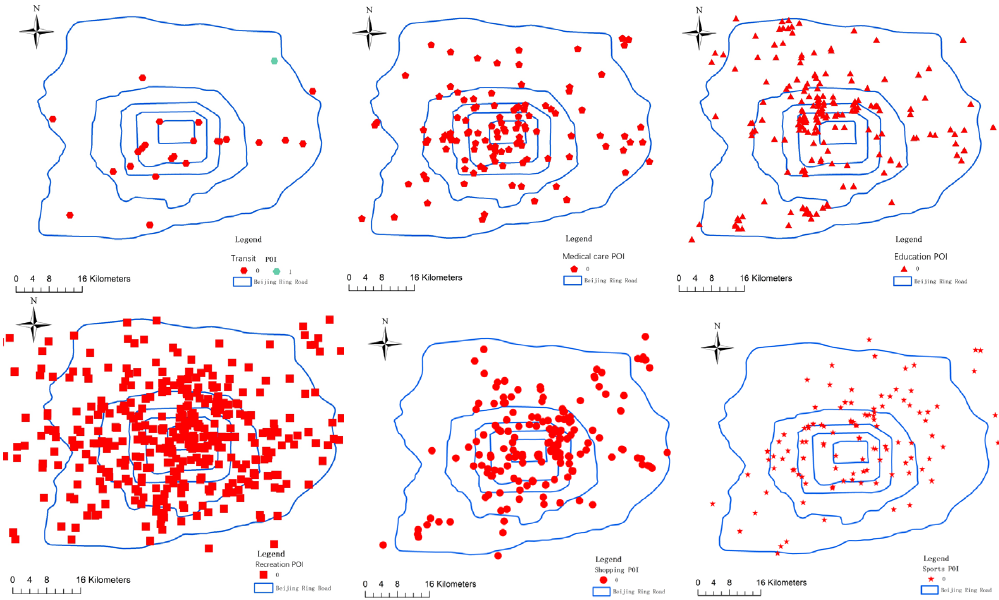
Figure 12. Patterns of changes in pedestrian flow at different hotspot locations in Beijing during the epidemic. ISPRS Int. J. Geo-Inf. 2021 , 10 , 479